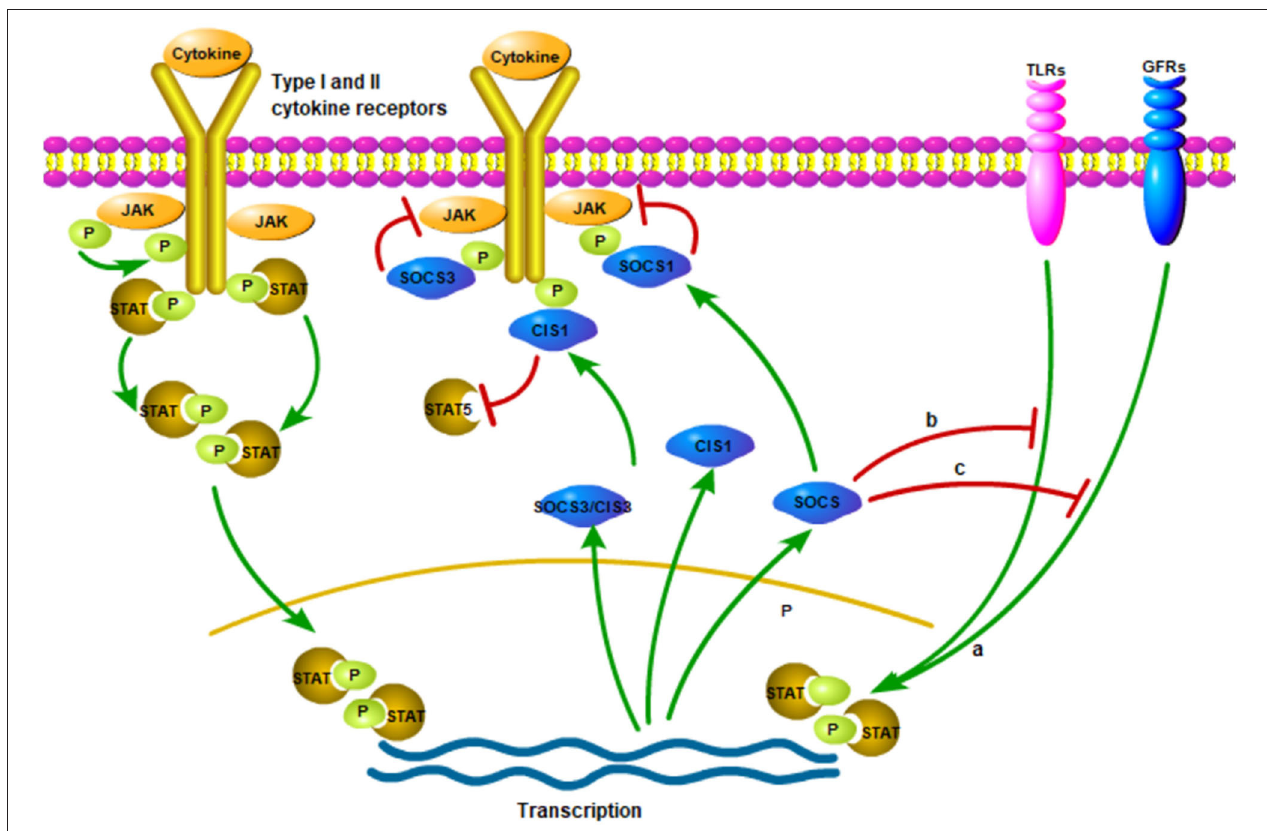
FIGURE 1 | The production and action of SOCS proteins. Various cytokine receptors can induce SOCS proteins expression in a JAK/STAT-dependent manner (Pictured on the left side). However, SOCS1, SOCS3 and CIS seem to suppress signaling in various ways. SOCS1 directly interacts with JAKs and reduce their catalytic activities while SOCS3 interacts with the proximal position and CIS blocks up with the binding sites of STATs to receptors. Moreover, it is possible to induce the production of SOCS proteins independent of JAK/STAT signaling pathways, such as signaling of TLRs, growth factor receptors (GFRs). (a) The SOCS proteins induced in these ways could inhibit the response of the cell to other cytokines, which is one of the modes of crosstalk inhibition. Finally, the inhibition of SOCS proteins may not be limited to the classic JAK/STAT signaling pathway (b,c). The figure is referenced from Figure 1 of Suppressors of cytokine signaling and immunity ( 14). The red line indicates inhibition; green line indicates promotion; P (in the green circle) indicates